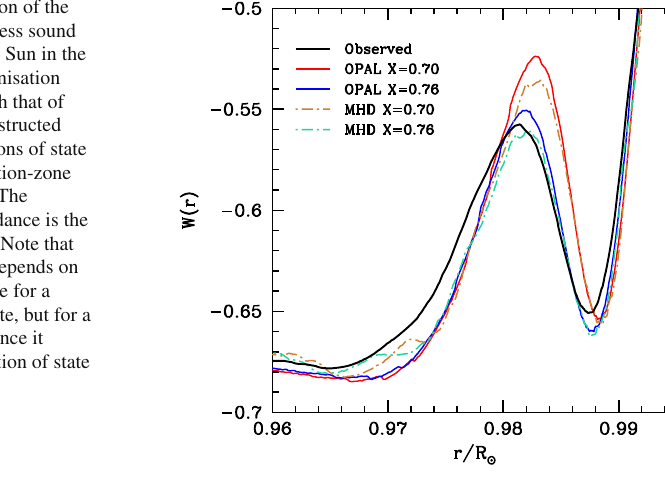
Fig. 19 A comparison of the observed dimensionless sound speed gradient of the Sun in the region of the He ii ionisation zone ( black line ) with that of different models constructed with different equations of state and different convection-zone helium abundances. The heavy-element abundance is the same for all models. Note that the height of W ( r ) depends on the helium abundance for a given equation of state, but for a given helium abundance it depends on the equation of